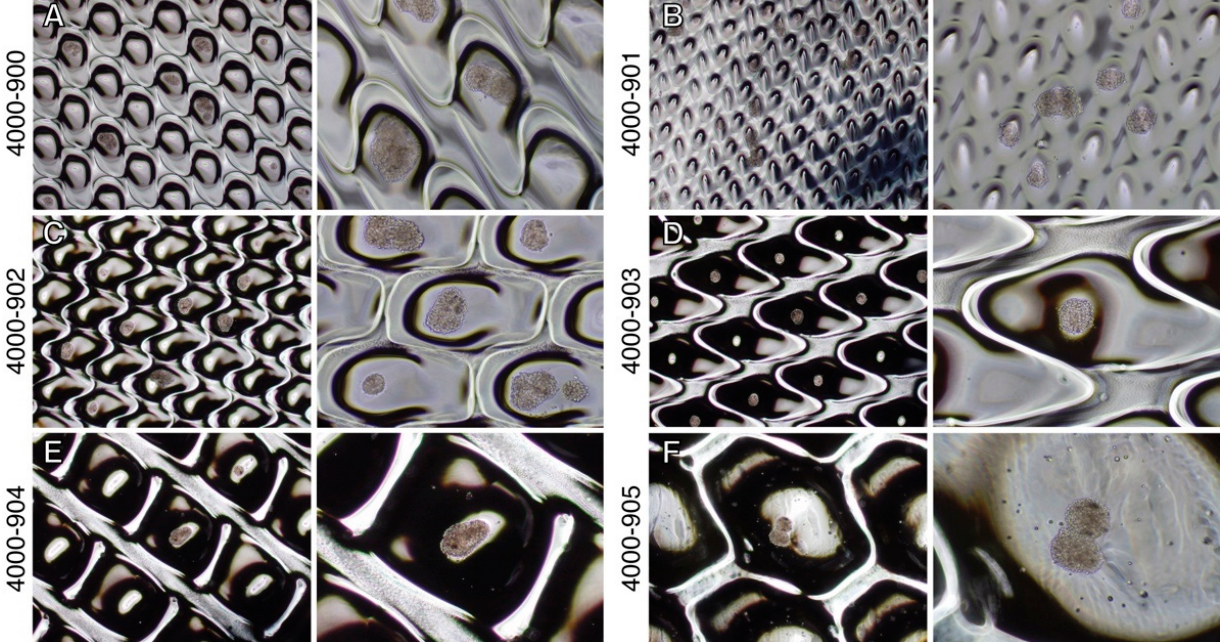
Figure 1. Cells cultured giving rise to spheroid forming units within EZSPHERE ® dish ( A ) type 4000-900, ( B ) type 4000-901, ( C ) type 4000-902, ( D ) type 4000-903, ( E ) type 4000-904, and ( F ) type 4000-905 at 4 × ( left ) and 10 × ( right ) magnification. Images visualized by inverted phase contrast microscope. 20,000 human nucleus pulposus cells were seeded per dish and cultured for 14 days at 5% CO 2 , 5% O 2 , and 37 °C.